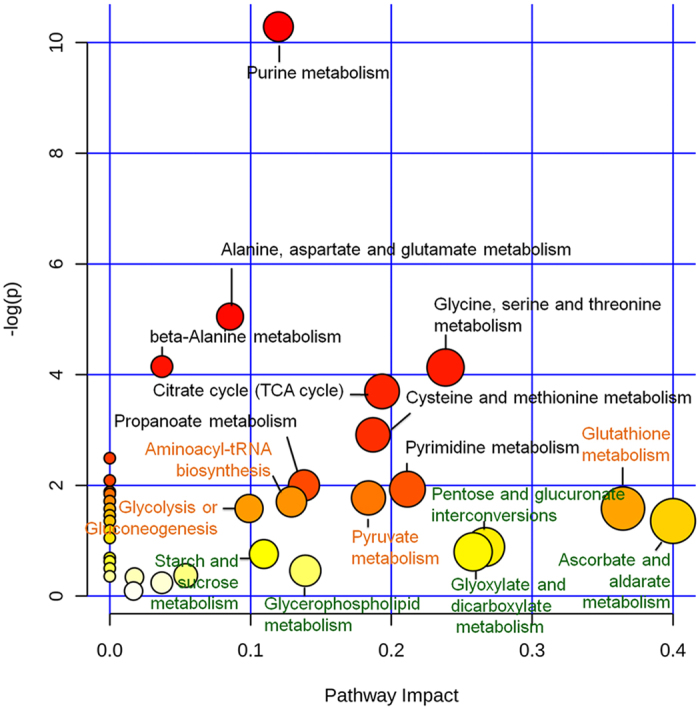
MetPA analysis of metabolic pathways.We analyzed the MetPA plot using the online software http://www.metaboanalyst.ca/, with default values as the analysis parameters. The deeper the red color of the metabolic pathway, the greater its -log (p) value, indicating a more significant difference. The darker the yellow color, the greater the impact of the pathway.